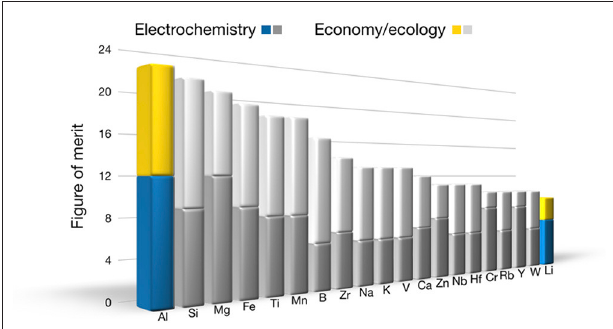
FIGURE 2 | Comparison between gravimetric and volumetric capacities, standard reduction potential and earth’s crust abundance of metal negative electrodes used or proposed for application in electrochemical storage systems (Fleischer, 1953; U. S. Geological Survey, 2015). Figure reproduced with permission from Elia et al. (2016) © 2016 WILEY-VCH Verlag GmbH & Co. KGaA,